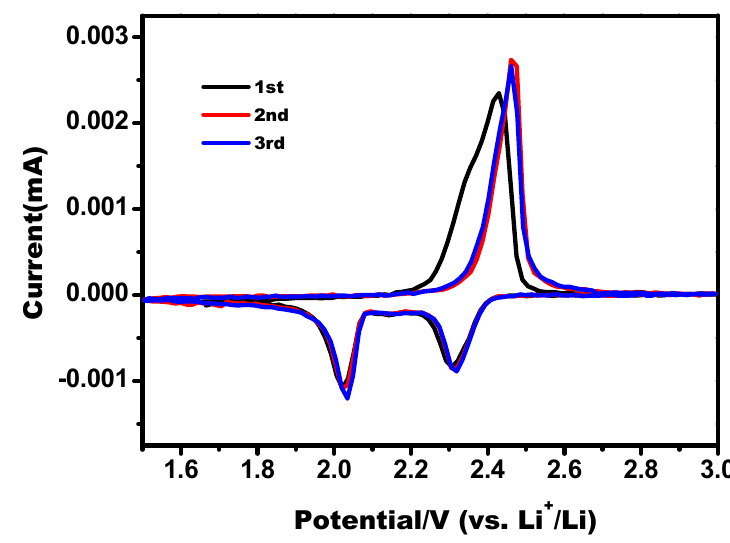
Figure 7. Cyclic voltammograms of S/AC/GA composites at a scan rate of 0.1 mV s − 1 .